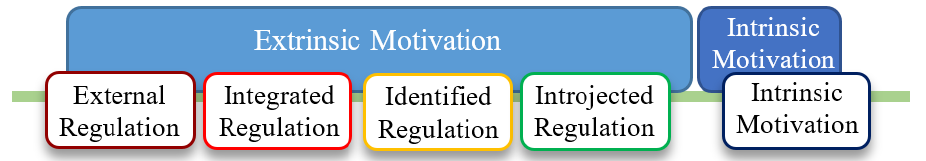
Figure 3. Extrinsic and intrinsic motivations.